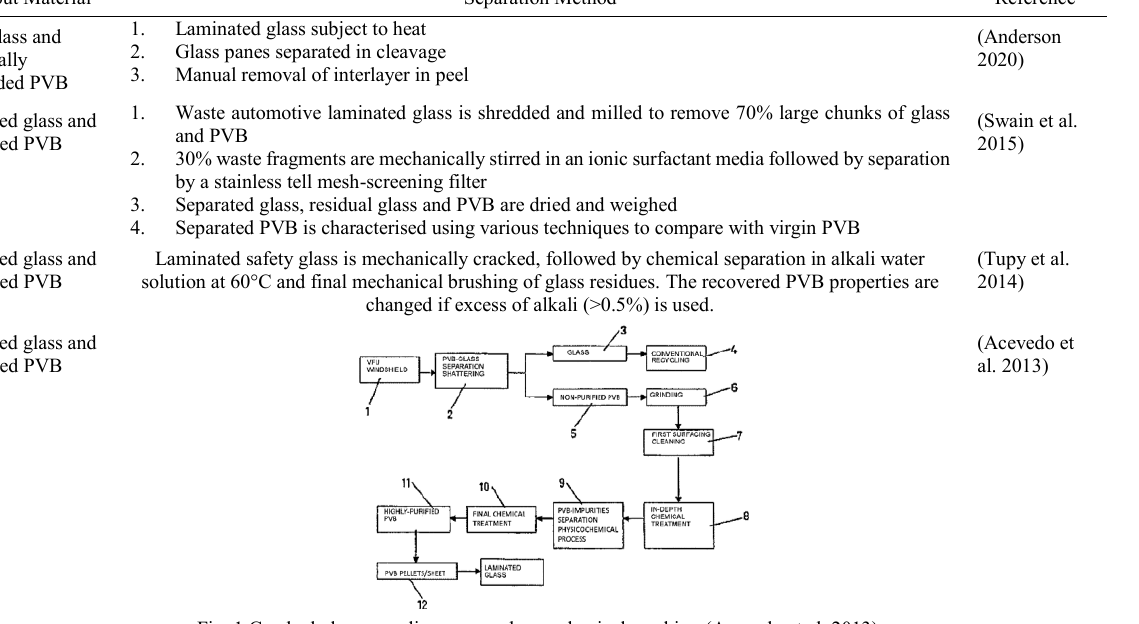
Table 1: Existing methods for re-use and re-cycling of PVB-laminated glass and characterization of re-cycled PVB interlayer. Output Material Separation Method Reference